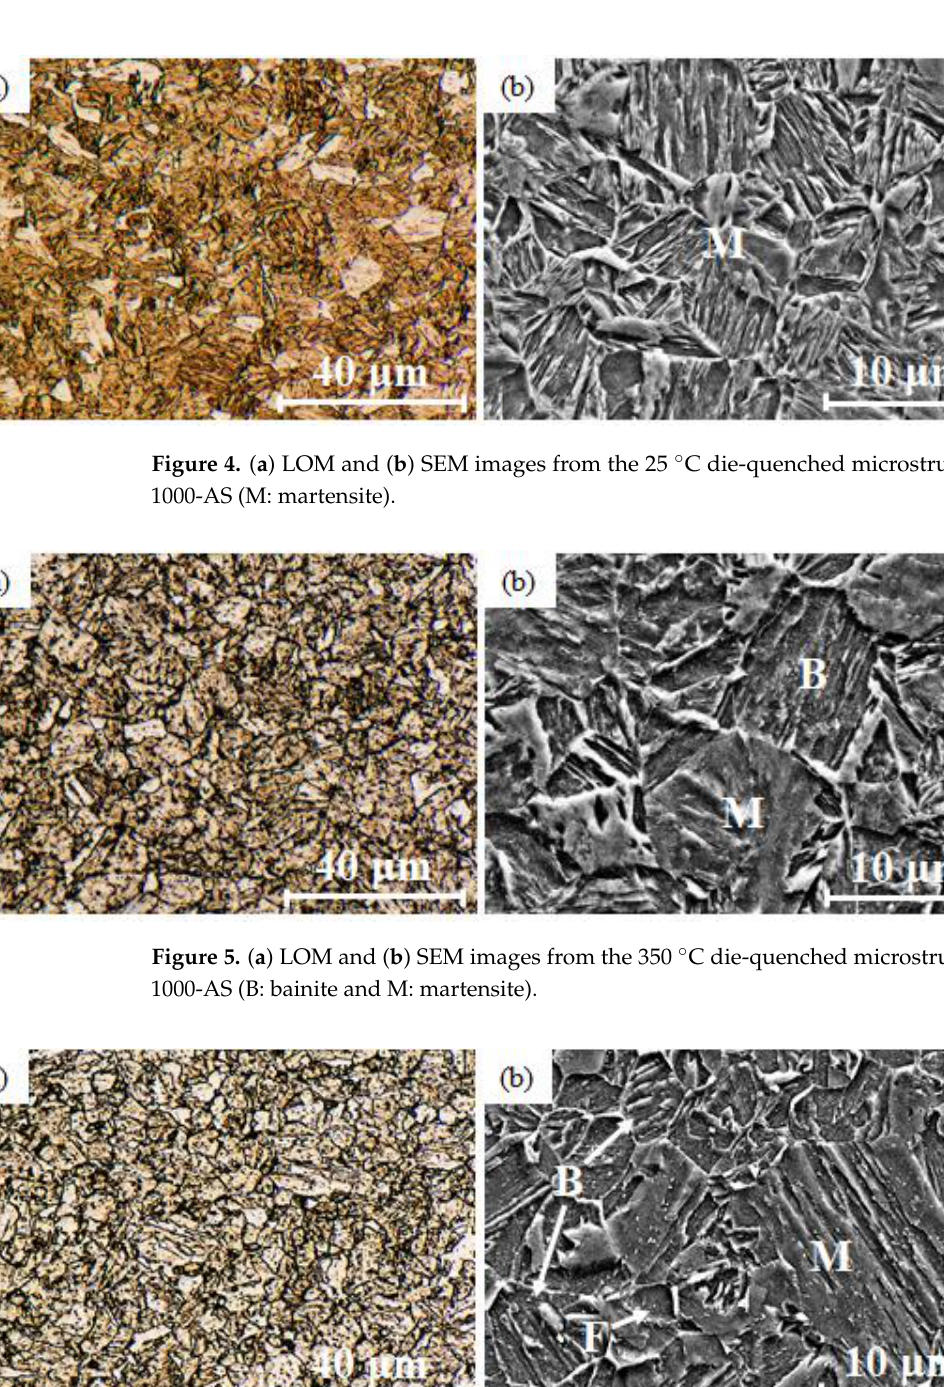
Figure 6. ( a ) LOM and ( b ) SEM images from the 450 °C die-quenched microstructure of Ductibor ® 1000-AS (F: ferrite, B: bainite, and M: martensite). Table 2. The measured hardness and micro-constituent volume fractions (%v) for the studied mi- crostructures of Ductibor ® 1000-AS.